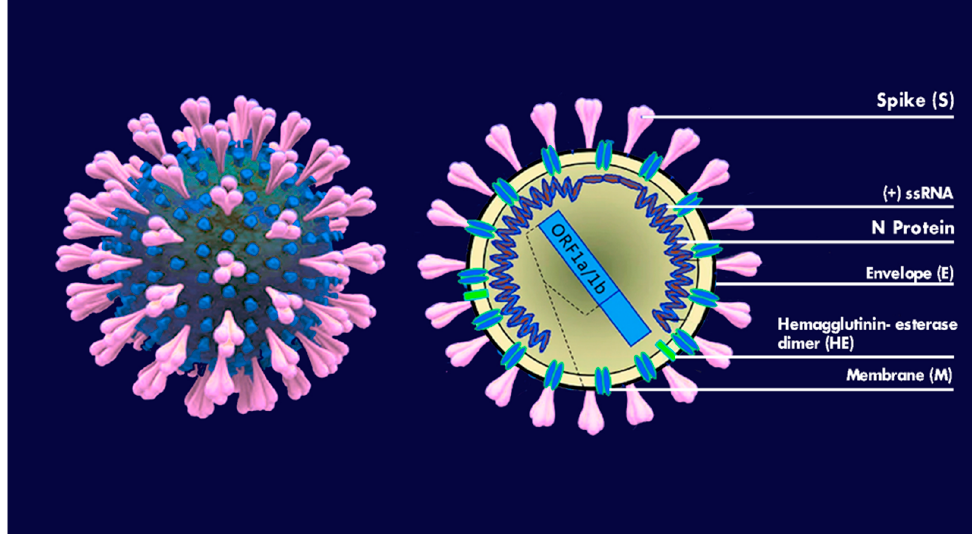
Figure 1. SARS-CoV-2. Spike Glycoprotein. RNA and N Protein, Envelope, Protein M, Hemagglutinin-esterase dimer (HE). Figure designed by Giovanna Dipalma.